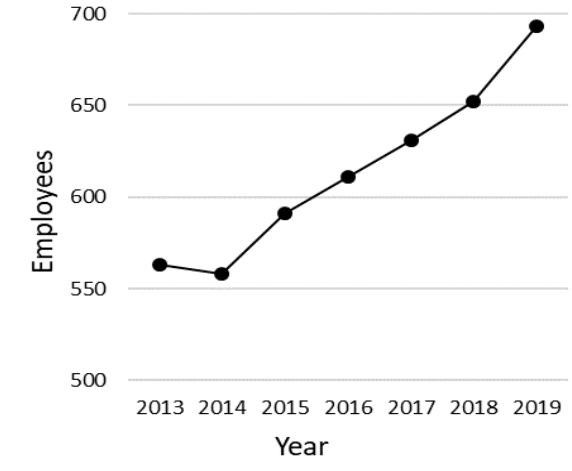
Fig. 8. Employment in the MD manufacturing sector in Latvia (the author’s